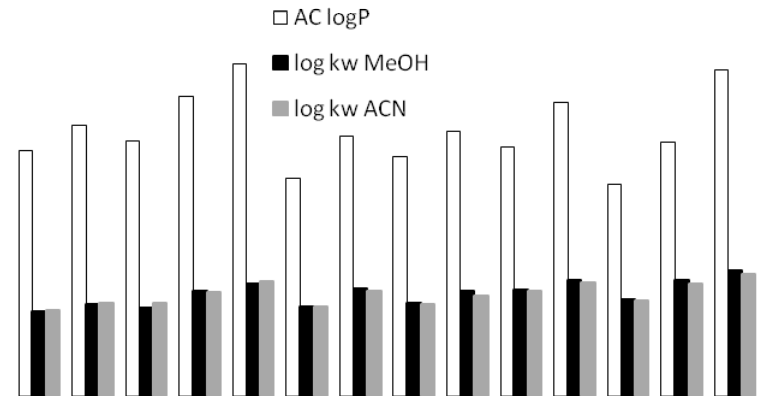
Figure 3. Comparison of different lipophilicity scales: chromatographic (log k w MeOH, log k w ACN, and calculated theoretically (AC log P ). Values were taken from the experimental database VCCLAB (ALIGPS 2.1).